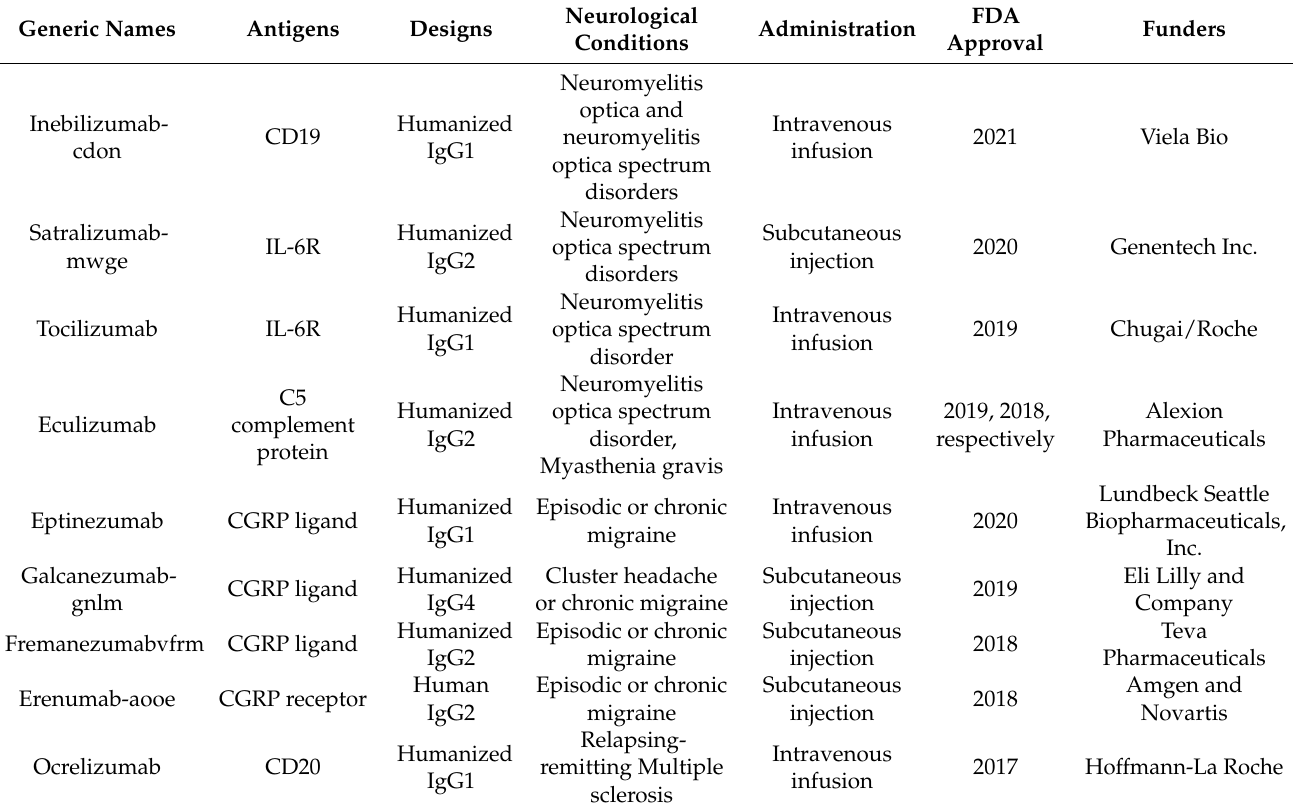
Table 1. Antibody-based drugs approved during 2017–2021 for neurological